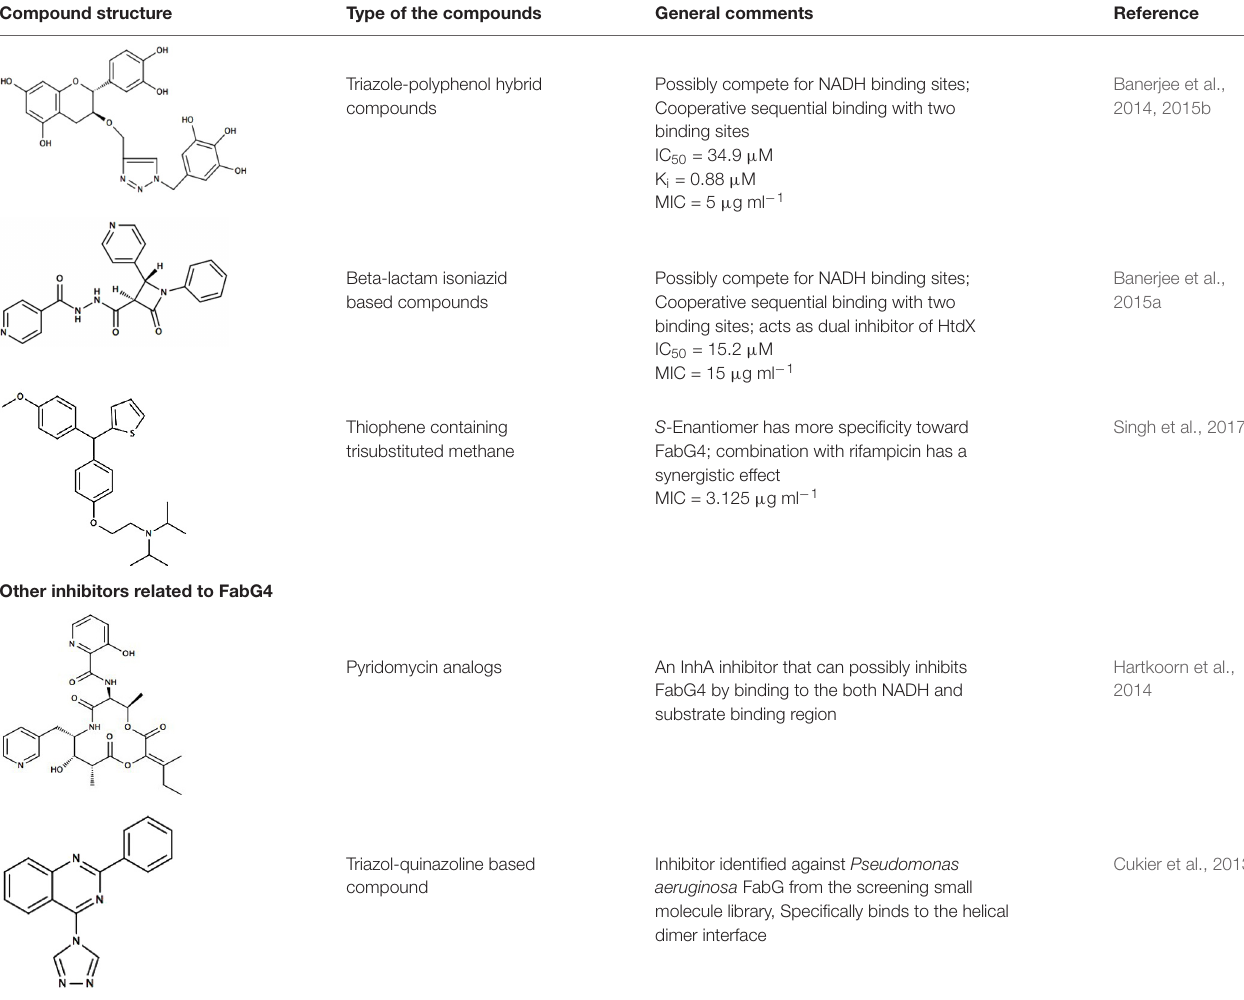
TABLE 1 | Inhibitors of FabG4. Compound structure Type of the